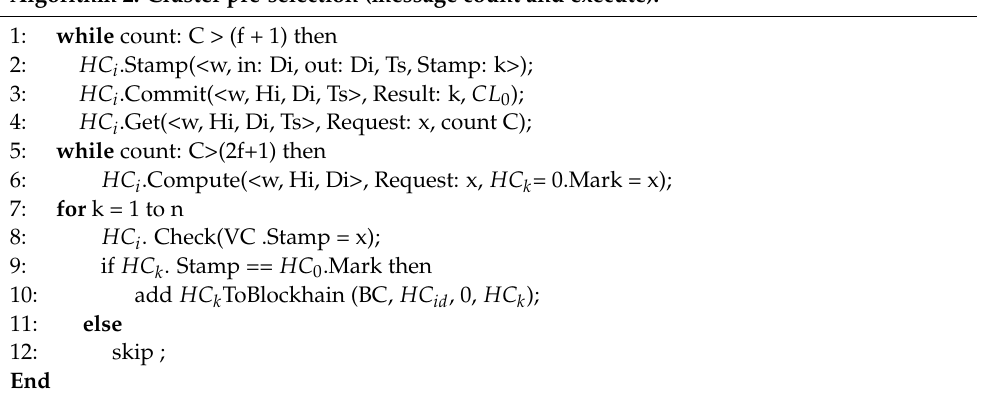
Algorithm 2. Cluster pre-selection (message count and